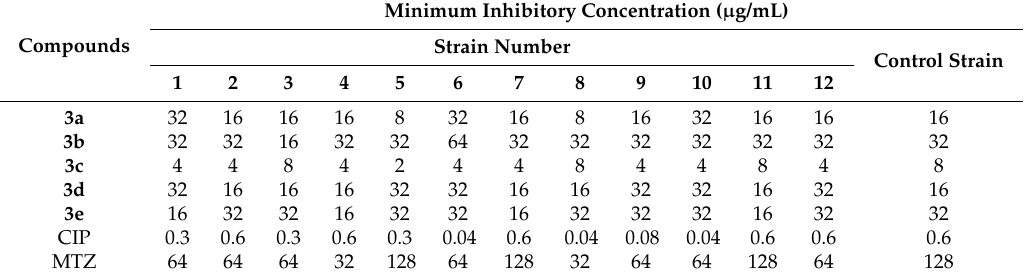
Table 2. Minimum inhibitory concentration (MIC, µ g/mL) of tested compounds and metronidazole against clinical strains of H. pylori ( 1 – 12 ) and control strain by two-fold agar dilution method.